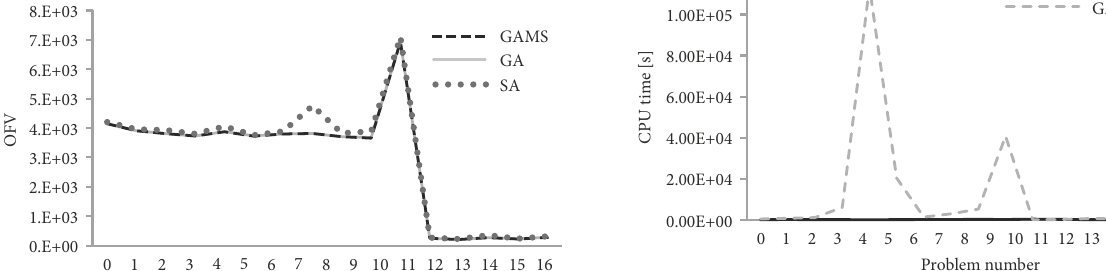
Figure 13. Computational results for small-sized instances